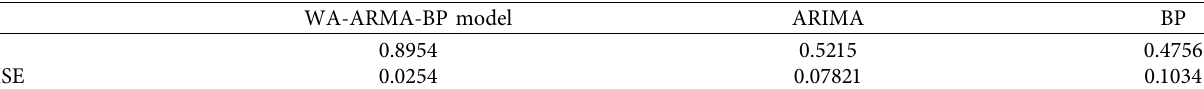
Figure 10: Scatterplot comparing observed and forecasted average groundwater depth using the best BP neural network model during the testing period. Table 5: The results of